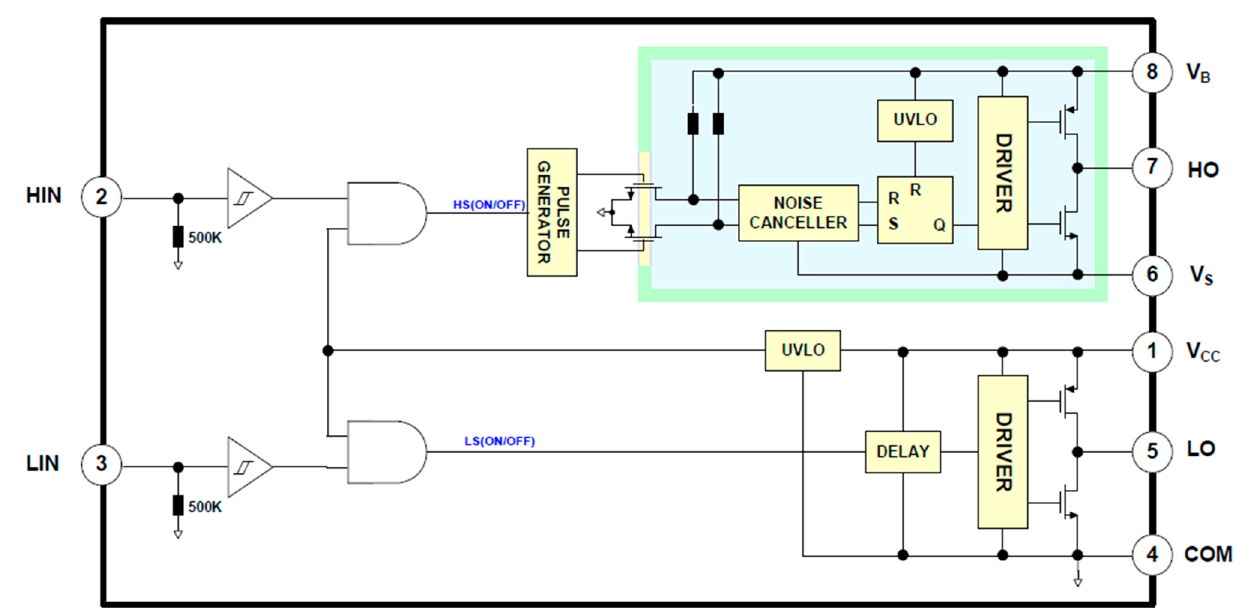
Figure 6. System of the gate driver IC FAN7842.